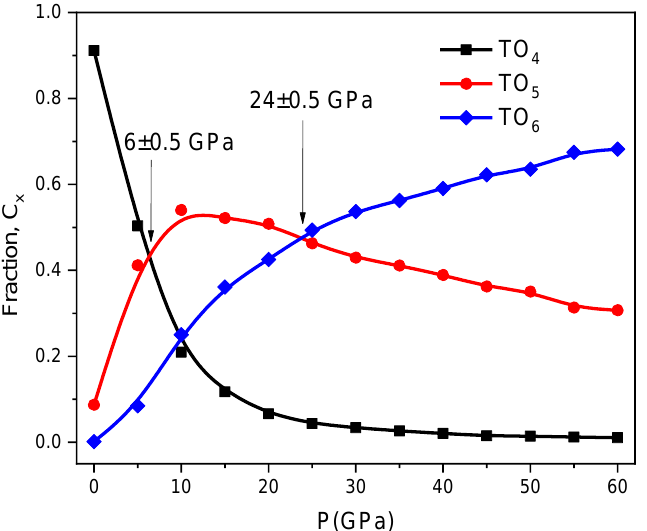
Figure 8. Pressure dependence of C TO4 , C TO5 and C TO6 fractions. Here, the black arrows present the phase transition points